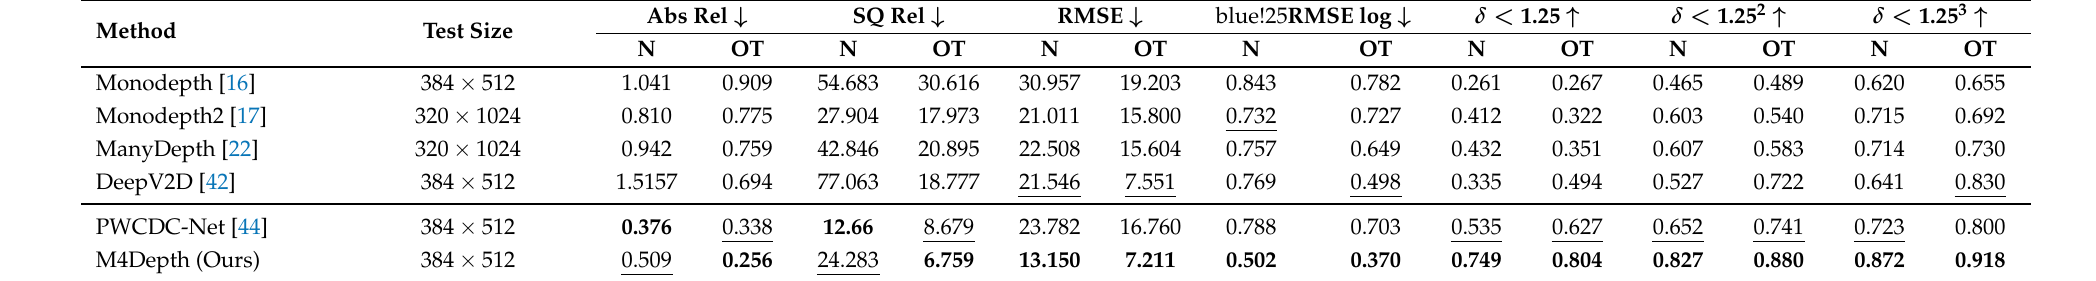
Table 5. Performance for the generalization test on two structured environments from TartanAir, that are neighborhood (N) and old town (OT). Scores were generated by using the same network weights as the ones used to report the performance on KITTI in Table 3. The best score for a metric is highlighted in bold and the second best is underlined. The four first metrics need to be minimized ( ↓ ) and the three last ones need to be maximized ( ↑